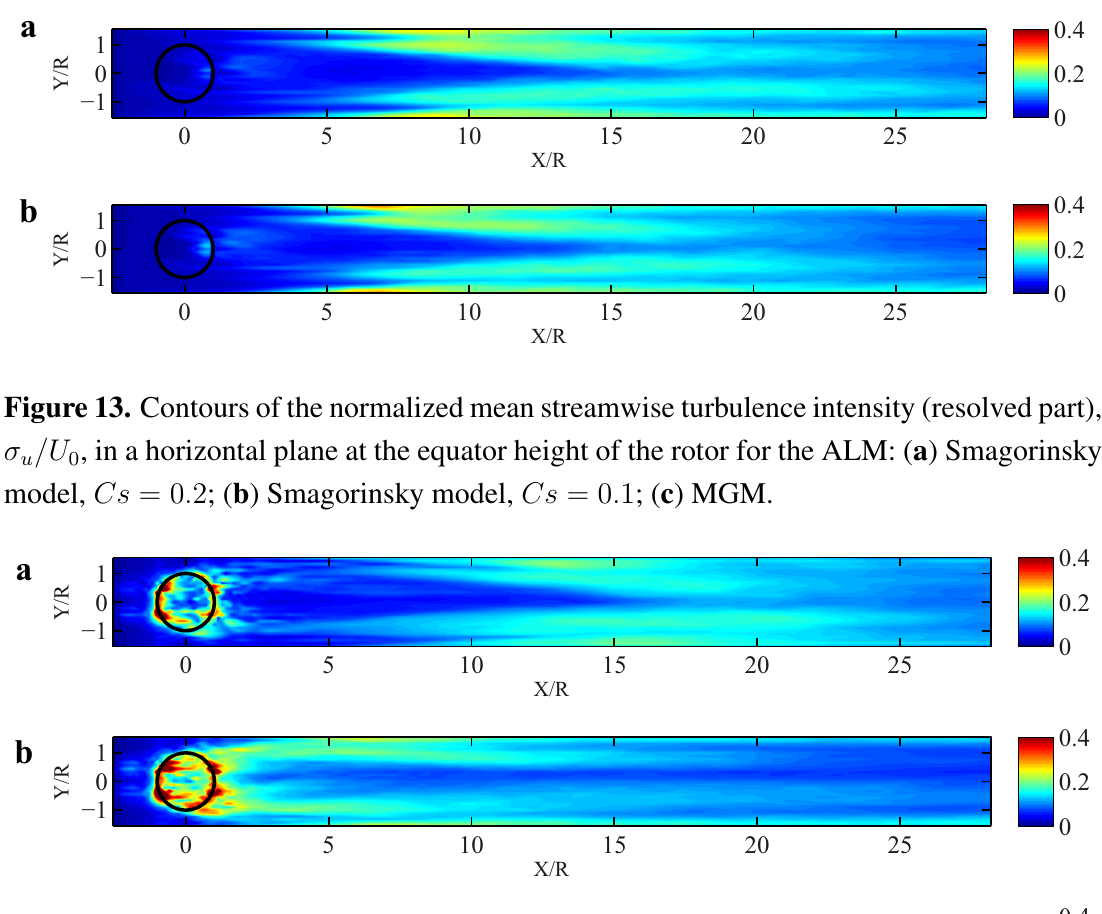
Figure 12. Contours of the normalized mean streamwise turbulence intensity (resolved part), σ /U , in a horizontal plane at the equator height of the rotor for the ASSM: ( a ) Smagorinsky u 0 model, Cs = 0 . 1 ; ( b ) MGM.